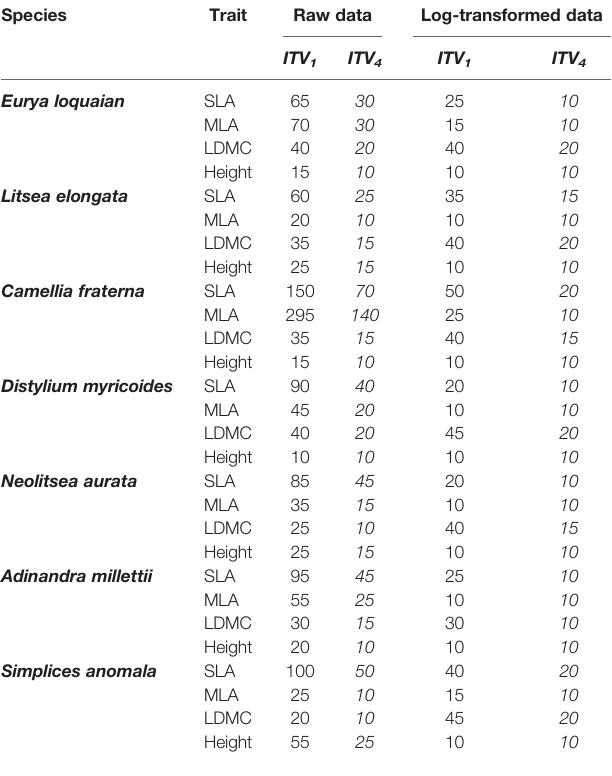
TABLE 2 | Minimum sample sizes of the most commonly used CV estimator CV 1 and our best-performed estimator CV 4 to reach ±5% accuracy for each trait (SLA, speci fi c leaf area; MLA, mean leaf area; LDMC, leaf dry mass content, Height, individual height) of each species with abundance ≥ 400 based on the raw and log-transformed Tiantong tree data.